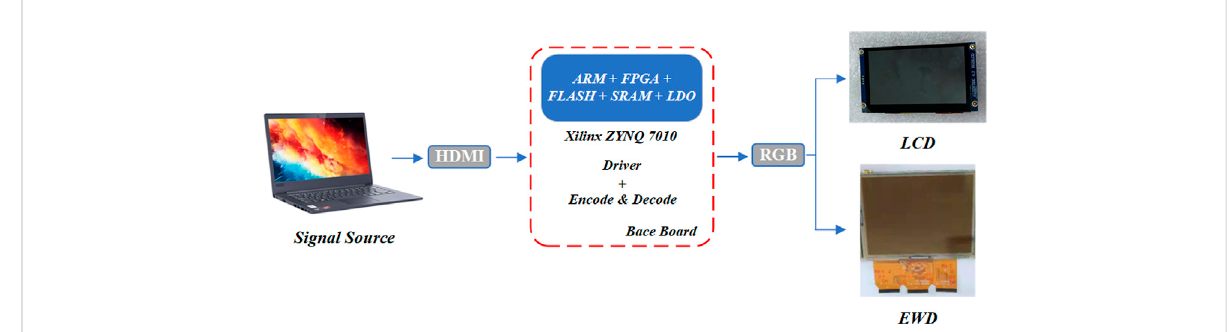
FIGURE 2 SchematicdiagramofthedrivingsystemfortheEWD.HDMIsignalisdirectlyconvertedintoRGBsignalbythesystemandoutputtoanLCDand an EWD.